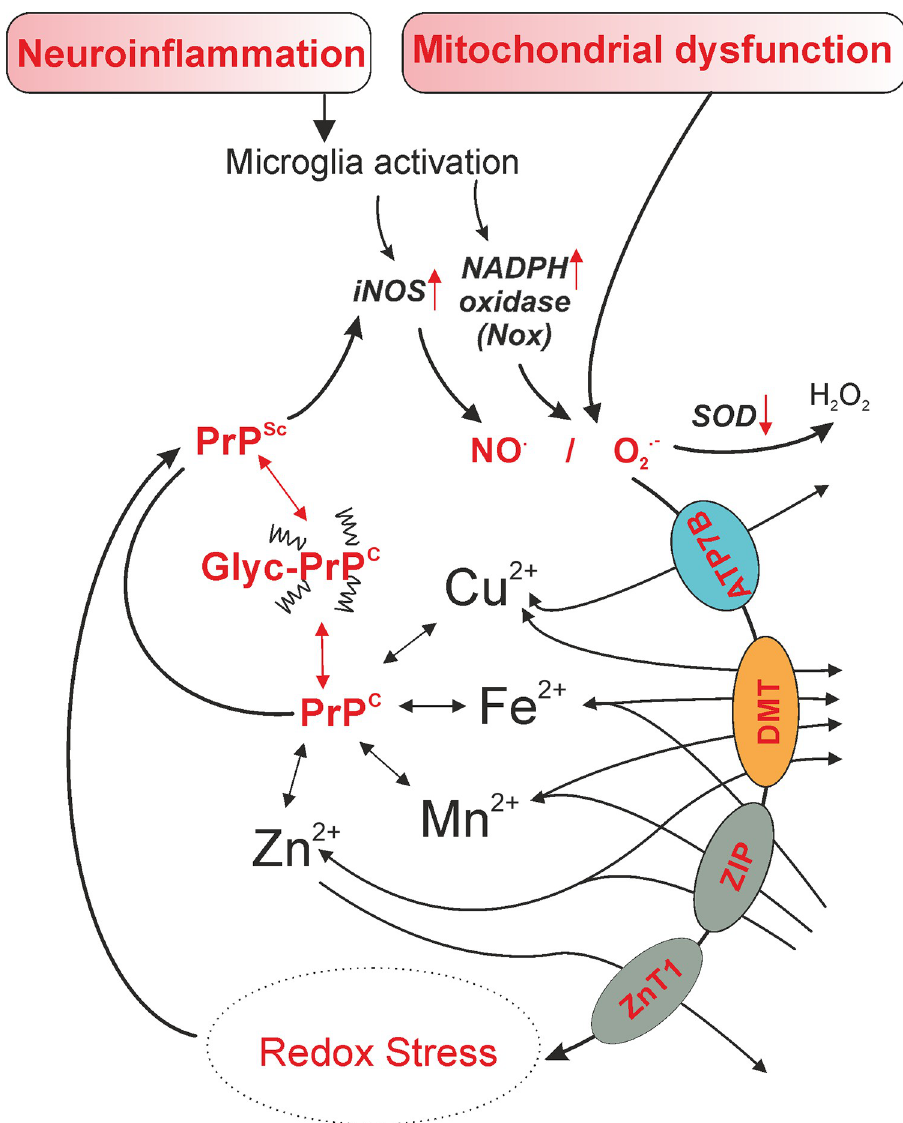
Fig 1. Hallmarks of prion disease pathogenesis include neuroinflammation and mitochondrial dysfunction, which facilitate production of reactive oxygen and nitrogen species via inflammatory-related enzymes including NADPH-oxidase (Nox) and inducible nitric oxide synthase (iNOS). These produce radical species such as superoxide (O 2 .- ) and nitric oxide (NO . ), respectively. Under normal conditions, antioxidants such as superoxide dismutase (SOD) would neutralise these radicals to less reactive species or reduce them to water. However, in pathological conditions such as prion disease where oxidant production is favoured, antioxidants are overwhelmed, which results in cellular redox stress. This is further exacerbated by the mobilisation of redox-active and transition metals such as iron (Fe 2+ ), zinc (Zn 2+ ), copper (Cu 2+ ), and manganese (Mn 2+ ), which causes dyshomeostasis in cellular biometal distribution through various divalent metal transporters (ZnT1, ZIP, DMT, ATP7B) and promotes oxidative stress. Together, these conditions may favour glycosylation of the native prion protein (PrP C ), which facilitates conversion to the disease isoform (PrP Sc ), further promoting disease